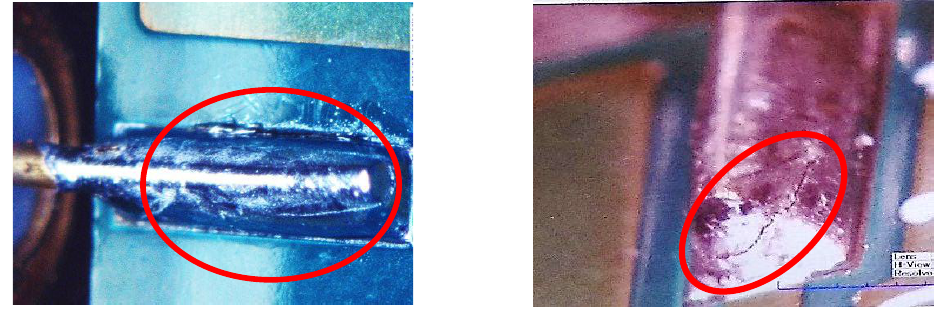
Figure 2. Photos of cracks in directly soldered structure.